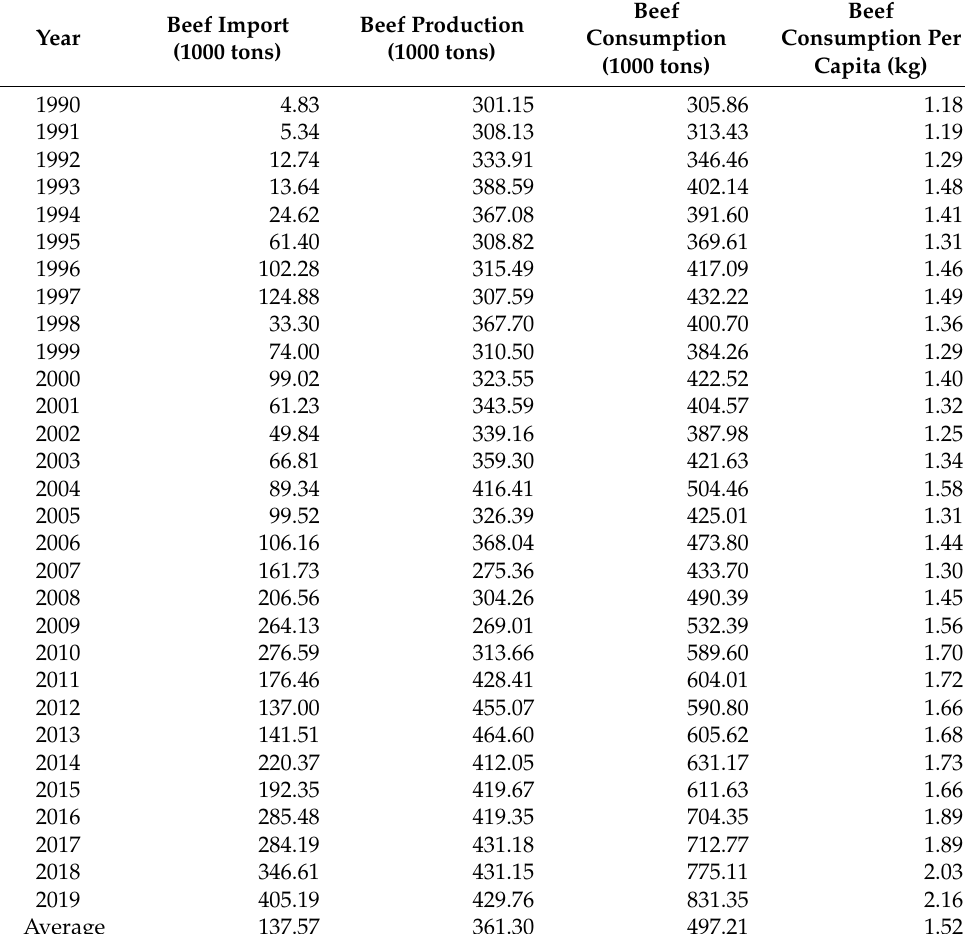
Table 1. Import, production, and consumption of beef in Indonesia during the period of